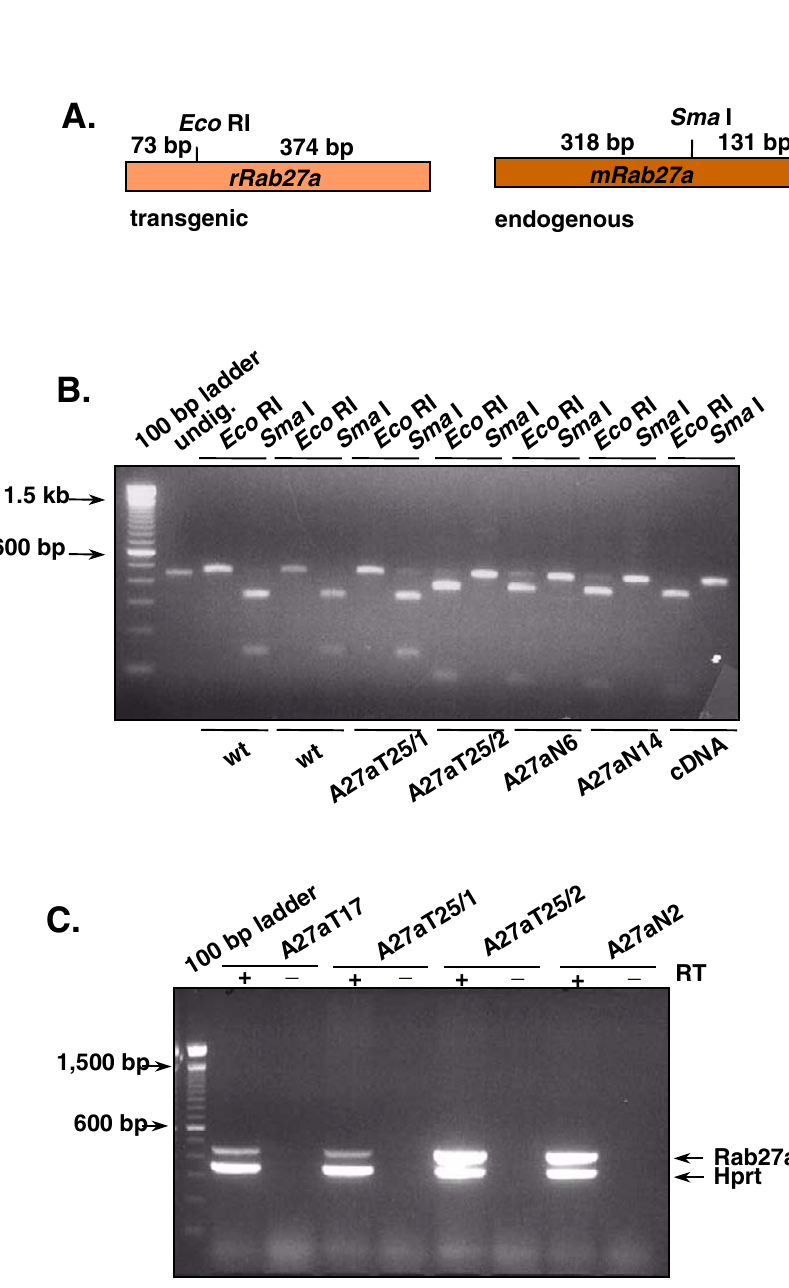
Figure 3 Detection of Rab27a mRNA. (Panel A) Schematic depiction of transgenic (rat) versus endogenous (mouse) Rab27a coding sequence. Eco RI or Sma I restriction sites as well as resulting fragment sizes are indicated. (Panel B) Comparison of transgenic versus endogenous Rab27a expression in the eye by RT-PCR and restriction digestion of PCR products. Rab27a mRNA from wild-type and independent mutant transgenic lines (Rab27a T23N and Rab27a N133I ) amplified by RT-PCR was digested with Eco RI or Sma I and electrophoresed as described under "Methods". Rat Rab27a cDNA was used as a control. (Panel C) Deter- mination of Rab27a expression (transgenic and endogenous) in eyes by RT-PCR (+). The oligonucleotides and conditions were as described under "Methods". The PCR products were analysed on an agarose gel stained with ethidium bromide. Reactions performed without reverse transcriptase are indicated (-). The arrows on the left-hand side indicate the positions of DNA marker sizes. Hprt expression was used as an internal